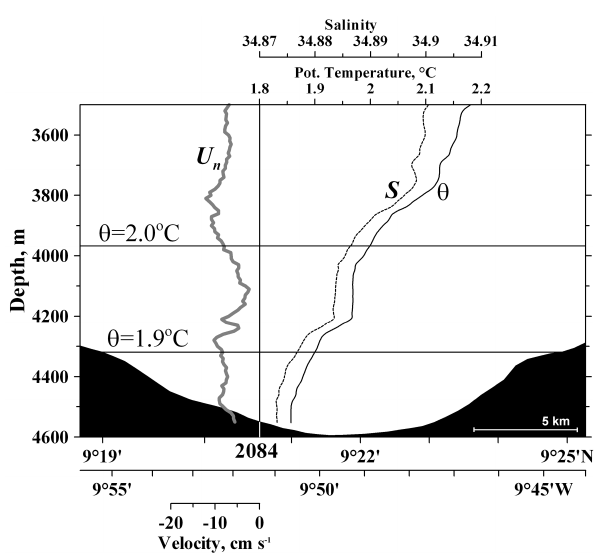
Fig. 5. Profiles of potential temperature ( ◦ C), salinity ( S ), and normal-to-section velocity component (cms − 1 ) measured in May 2009 at station AI 2084 over the sill of the Kane Gap. Positive velocities of the flow are directed to the northwest. The horizontal scale is shown in the bottom right corner. The hill in the bottom to- pography shown in Figs. 6–7 is located to the northwest of the line shown